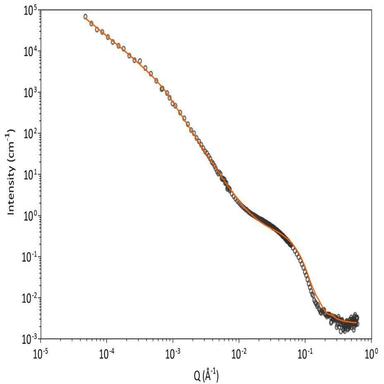
Merged SANS and desmeared USANS data for SLN. The red line is a customized Guinier–Porod + ellipsoidal fit across the entire q range, i.e., 4.71 × 10− 5 Å− 1 - 6 × 10− 1 Å− 1 . Reprinted with permission from. Copyright American Chemical Society. SANS data collected on Quokka and USANS on Kookaburra at ANSTO. (For interpretation of the references to colour in this figure legend, the reader is referred to the web version of this article.)